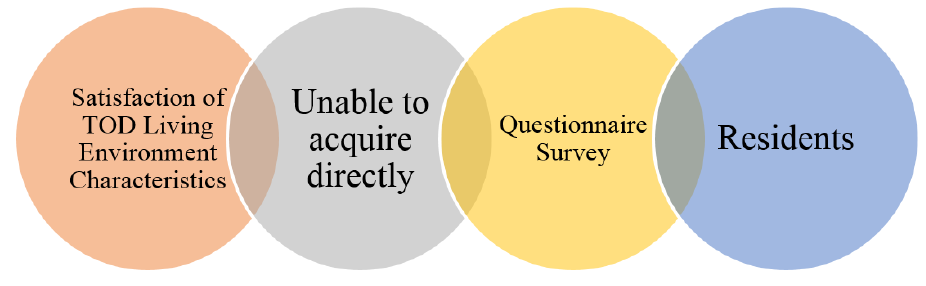
Figure 4. Information collection framework drawing.